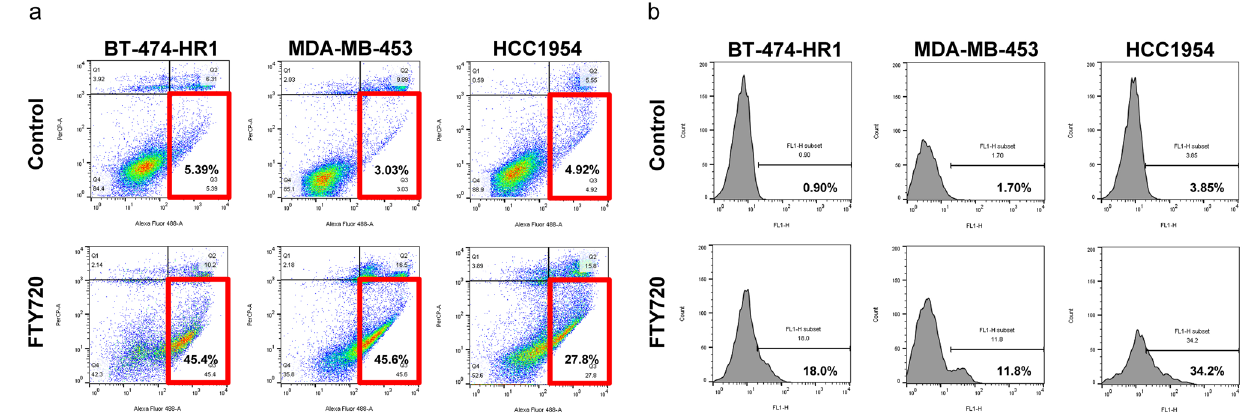
Figure 4. FTY720 triggers apoptotic events in trastuzumab-resistant cell lines. ( a ) The three trastuzumab- resistant cell lines were treated with DMSO only as control or FTY720 at IC 50 for 24 h. Cells were then stained with annexin V and analyzed using flow cytometry to determine the proportion of apoptotic cells. The x-axis indicates Alexa Fluor 488-A, whereas the y-axis indicates PerCP-A. ( b ) TUNEL assay kits were utilized to compare the percentage of apoptotic DNA fragmentation after DMSO and FTY720 treatment at IC 50 . The incubation time was 32 h for BT-474-HR1 and 40 h for MDA-MB-453 and HCC1954. The x-axis indicates FL1- H, whereas the y-axis indicates cell Figure S5c). The percentage of DNA fragmentation increased from 0.90 to 18.0%, 1.70 to 11.8%, and 3.85 to 34.2% in BT-474-HR1, MDA-MB-453, and HCC1954 cells, respectively. Prominent apoptotic events were also be demonstrated by increased sub-G0 cells after adding FTY720 (Figure S4).